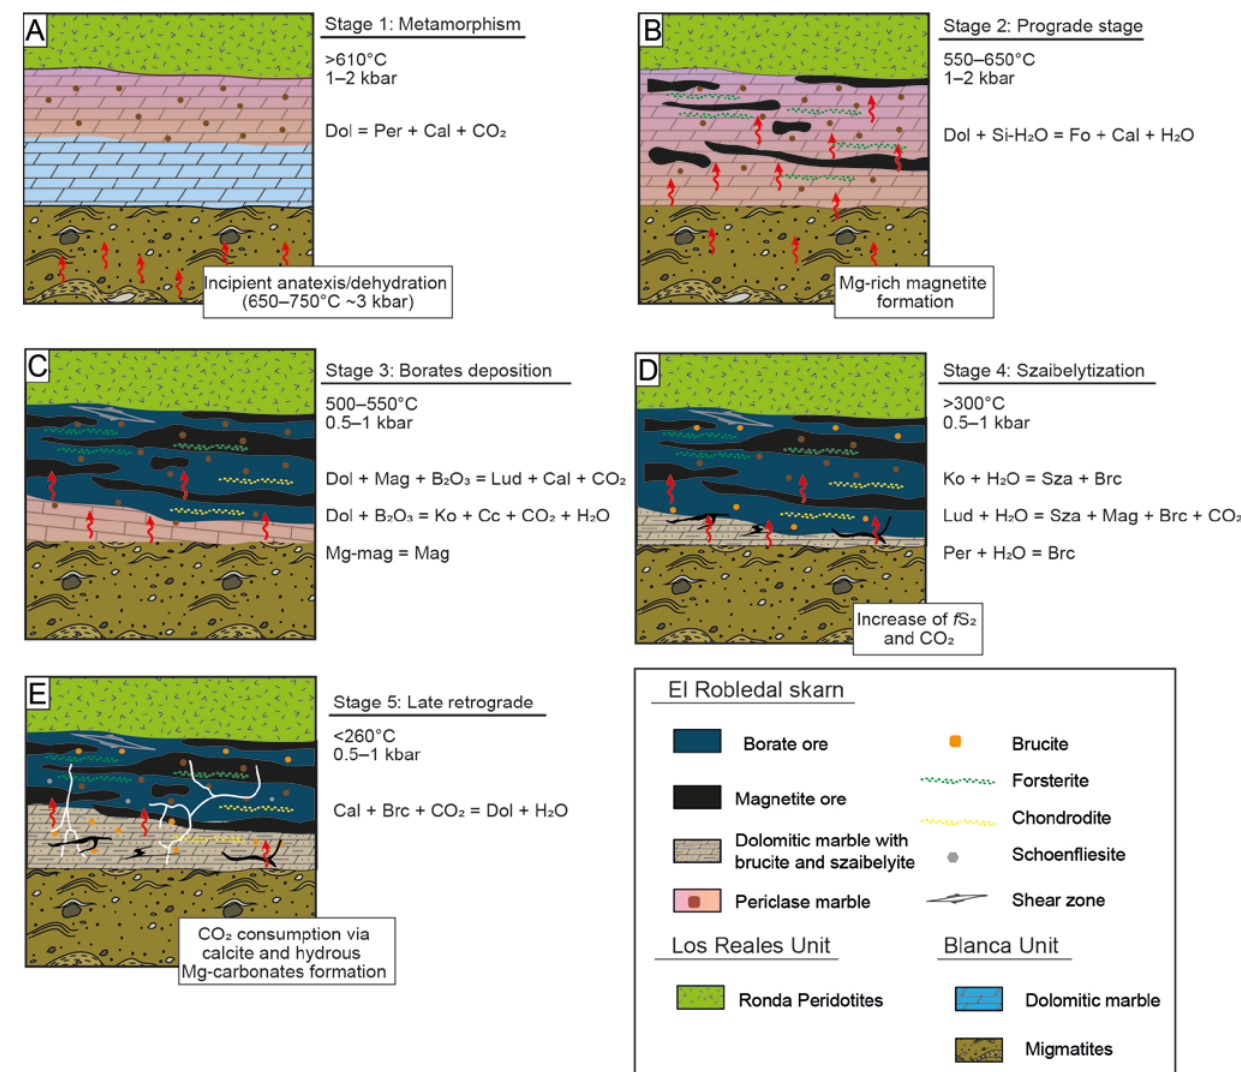
Figure 14. A proposed genetic model for the El Robledal deposit formation. Red arrows represent the percolating mineralizing fluids released from migmatite. ( A ) Metamorphic stage. The heat provided by the ultramafic rocks promoted dolomite decomposition and periclase formation. Flu- ids/melts emanating from incipient anatexis should not have interacted with the dolomites of the Blanca unit during this stage. ( B ) Prograde stage. The interaction of mineralizing fluids emanating from migmatites and dolomite of the Blanca unit led to olivine and Mg-rich magnetite formation. ( C ) Further fluid/rock interaction promoted kotoite and ludwigite formation in the outermost part of the skarn. ( D ) Retrograde stage. The decreasing temperature of the mineralized fluids led to pri- mary borate alteration into szaibelyite and B-bearing brucite. Such a process is widespread close to the fluid source (i.e., migmatites) where the fluid/rock ratio is expected to be higher than in the zone close to the ultramafic rocks. ( E ) Late retrograde stage. The former reactions promote an increase of CO 2 and thus enhanced hydrous-carbonate formation. In zones of fractures, the excess of CO 2 should have been channelized generating hydrous Mg-carbonates and calcite veins.